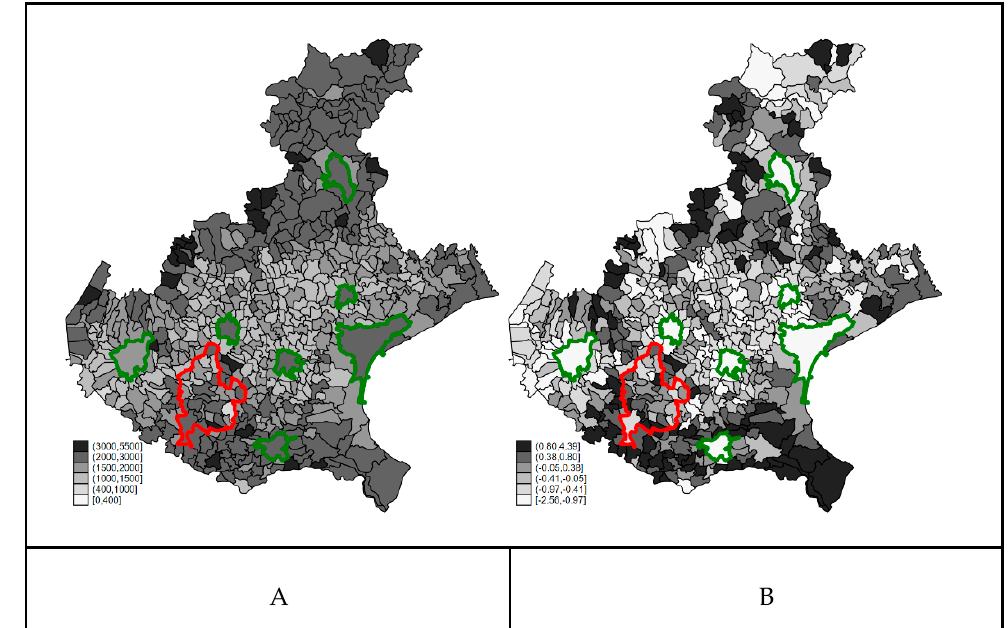
Figure 2. Panel ( A ): Smoothed mortality rates (×100,000) for all cause (January–April 2015–2019); Panel ( B ): Education score (the higher the score, the lower the education level) at the 2011 census. Veneto Region. Borders of the Red Zone are highlighted in red, and those of the main cities of the region are highlighted in green.